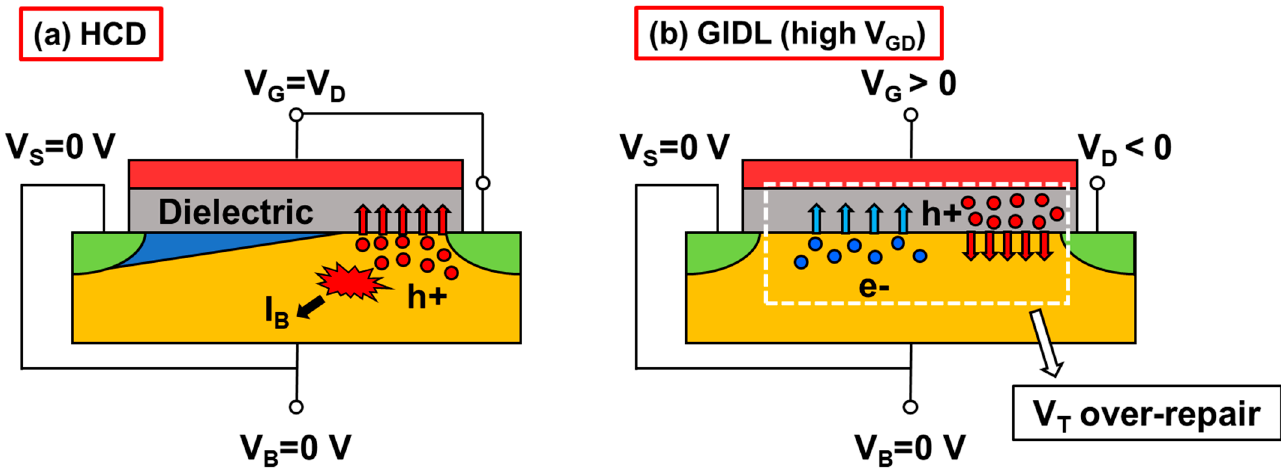
Figure 8. Schematic diagrams during ( a ) HCD and ( b ) GIDL repair with high V GD . H+ and e- are short for holes and electrons in the channel, respectively.